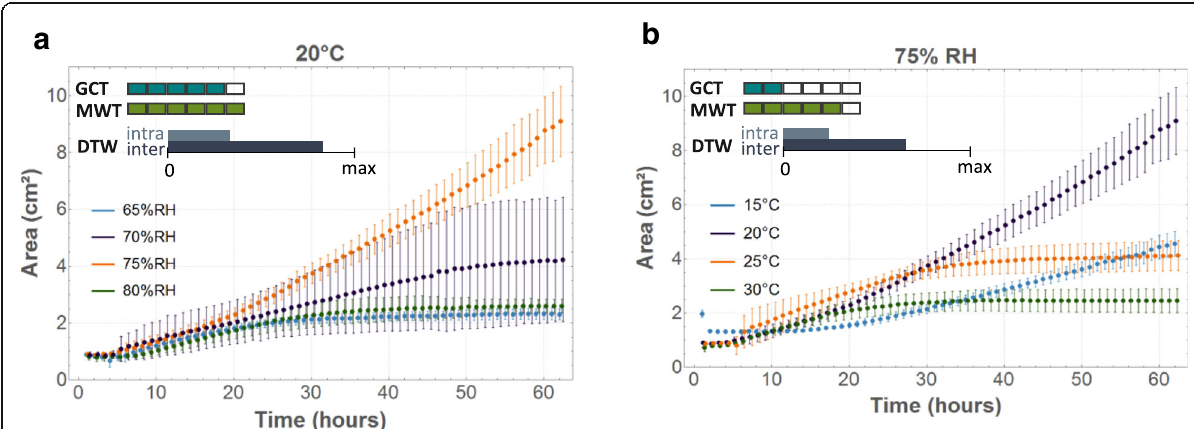
Fig. 5 Evolution of mycelial area (cm 2 ) over time for C. puteana at 20 °C ( a ) and 75%RH ( b ), showing a clear combined effect of temperature and RH. The dots represent the mean values over four replicates, with the bars indicating the standard deviation. For each graph, six pairwise GCT and MWT were performed between the four conditions represented in that graph. The two colour scales indicate for how many of those pairwise comparisons a difference was found according to GCT (blue) and MWT (green). The third scale represents the difference between the average DTW distance between the four conditions represented in the graph and a reference ground value, being the average DTW distance over the replicates in that graph. The bigger the bar, the more difference there is between conditions. When the DTW scale is negligibly small, the difference between conditions is insignificant compared to the reference DTW difference between